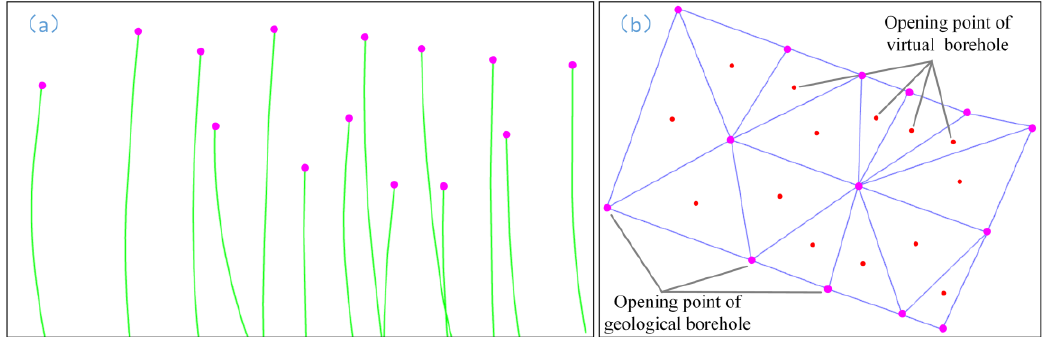
Figure 2. Determination of the Virtual Borehole Position ( a ) Original Geological Borehole Data; ( b ) Virtual Borehole Position.